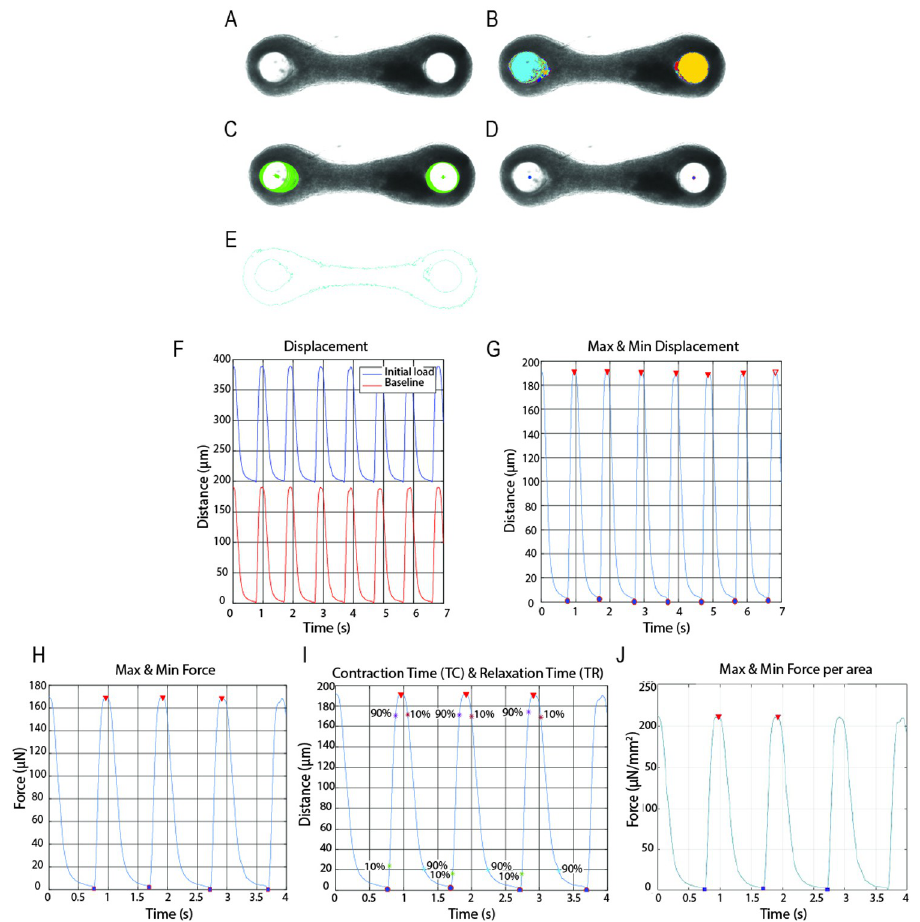
Fig 5. EHT contraction analysis on transparent pillars. (A) Original bright field image of an EHT around transparent pillars. (B) Region detection of the tip of the pillars from a bright field image. (C) Detection of the regions with low eccentricity. (D) Detection of the center of the pillars. (E) Contour of the EHT. (F) Displacement of the pillars over time with resting tension (Blue) and after removing the initial resting tension (Red). (G) Maximum and minimum detection of the contraction motion; complete contraction cycles are with filled marks. (H) Graph of the contraction force with the maximum and minimum.(I) Graph of displacement over time with the time to achieve 10% and 90% of contraction and relaxation. (J) Graph of force per surface area with maximum and